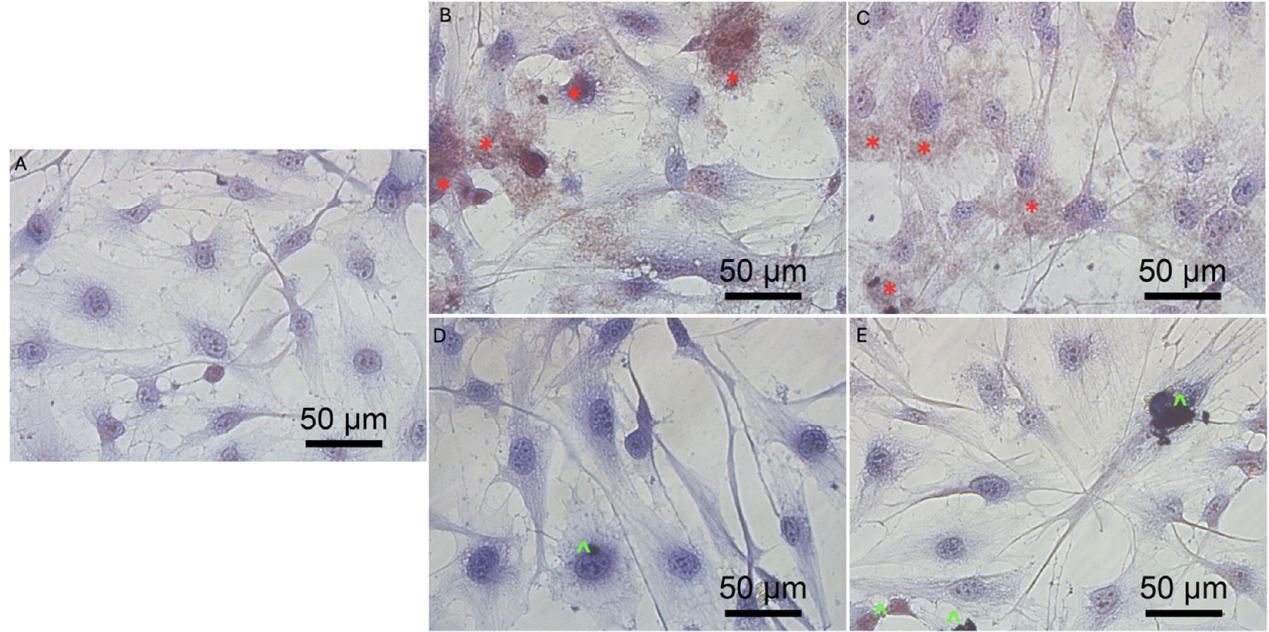
Figure 6. Morphology of U118 glioblastoma cells. ( A ) untreated cells (control group), cells treated with graphene oxide at concentration: 5µg/mL ( B ), 100µg/mL ( C ), and reduced graphene oxide at concentration: 5 µg/mL ( D ) and 100 µg/mL ( E ). Red * GO at cell membrane. Green ^ rGO at cell membrane. Light optical microscopy. Scale bars: 50 µm. ( A – E ). Abbrevi- ations: GO: graphene oxide, rGO: reduced graphene oxide.